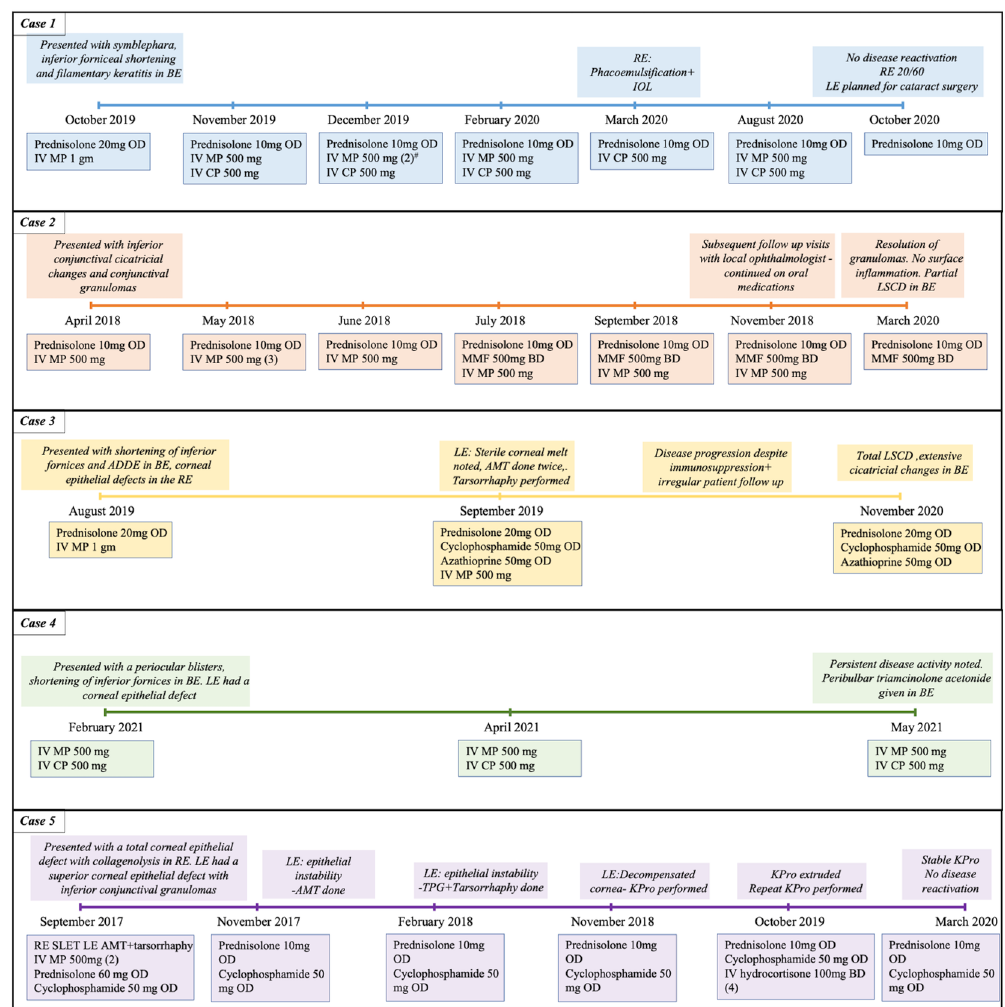
mide, TPG: tenons patch graft, AMT: amniotic membrane transplantation, SLET: simple limbal epithelial transplant, LSCD: limbal stem cell deficiency, KPro: keratoprosthesis. The numbers in brackets indicate the number of doses, if more than one was